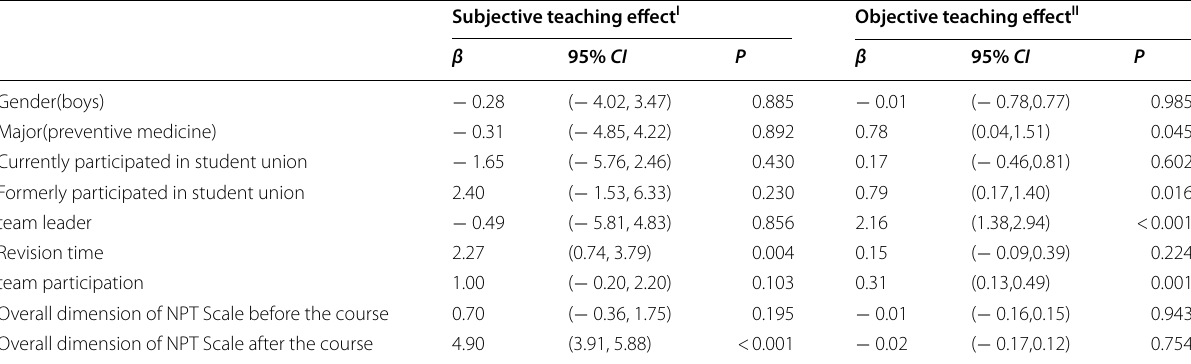
Model I: multiple linear regression model; Model II: linear mixed